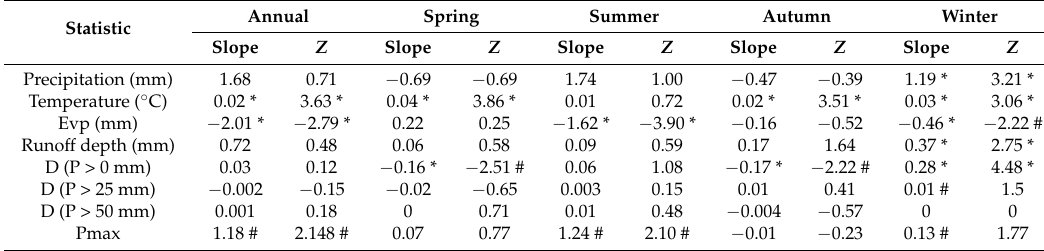
Table 2. Statistical information of trend analysis for the hydro-meteorological variables on annual and seasonal scales between 1960 and 2012 for the Qingliu River basin, East China. Annual Spring Summer Autumn Winter Statistic Slope Z Slope Z Slope Z Slope Z Slope Z Precipitation